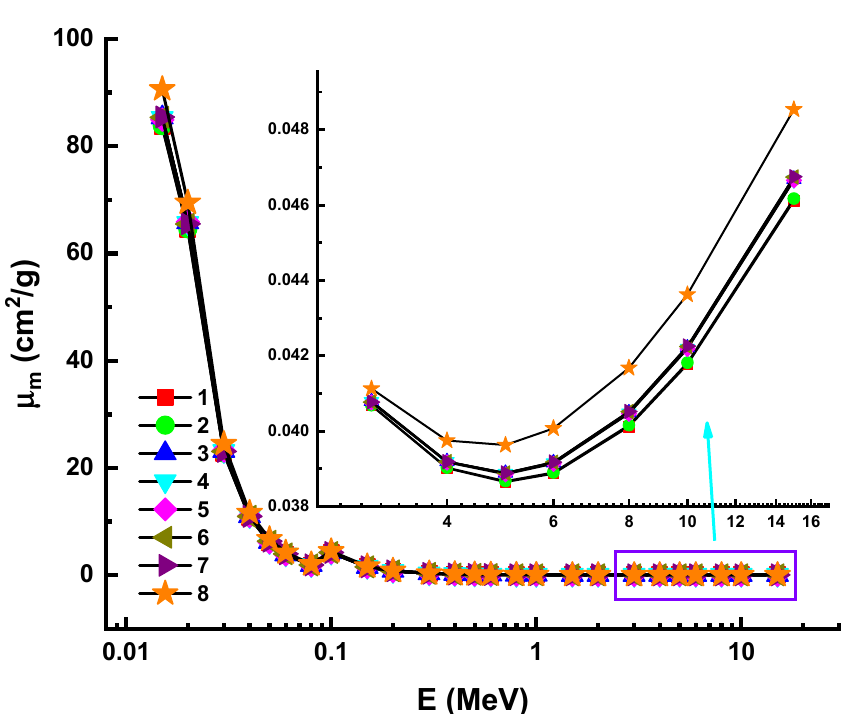
Figure 2. Variation of mass attenuation coefficient ( µ m ) against photon energy for all glasses. 1—37.5Bi 2 O 3 –62.5B 2 O 3 ; 2—38Bi 2 O 3 –60B 2 O 3 –2Al 2 O 3 ; 3—40Bi 2 O 3 –60B 2 O 3 ; 4—40Bi 2 O 3 –59B 2 O 3 –1Al 2 O 3 ; 5—40Bi 2 O 3 –59B 2 O 3 –1Y 2 O 3 ; 6—40Bi 2 O 3 –59B 2 O 3 –1Nd 2 O 3 ; 7—; 8—40Bi 2 O 3 –59B 2 O 3 –1Eu 2 O 3 .